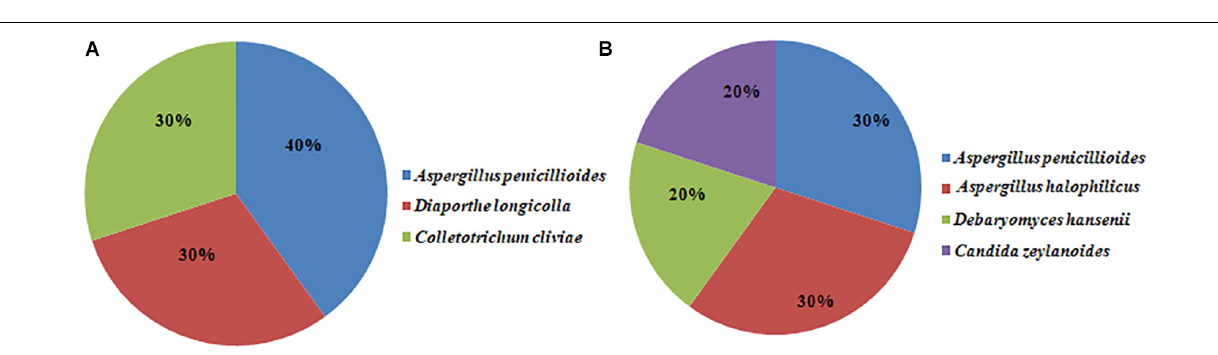
FIGURE 8 | Networks of microbial interaction in the spiced doushen samples. Circle is on behalf of the species, size of the circle represents the abundance. Lines represent the correlation between the two species, line thickness to represent the strength of the correlation, the color of the line: orange represents the positive correlation, green represents the negative correlation.